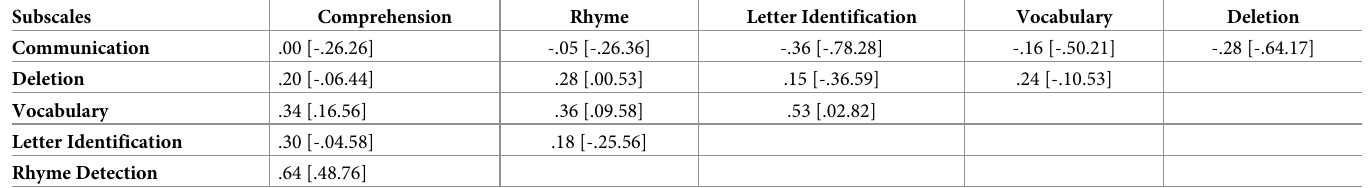
Table 5. Correlation coefficients between educators’ random